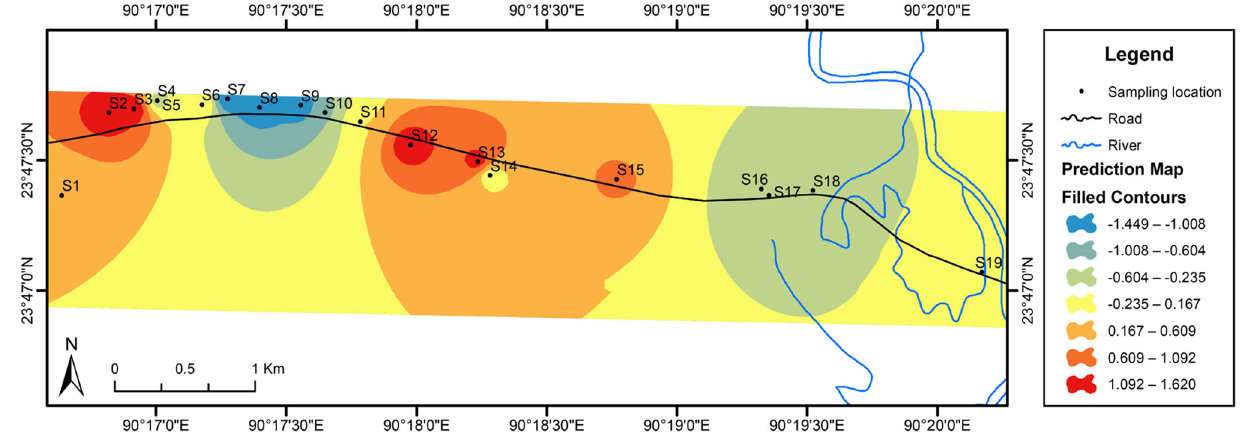
Fig. 8 Factor score map of principle component